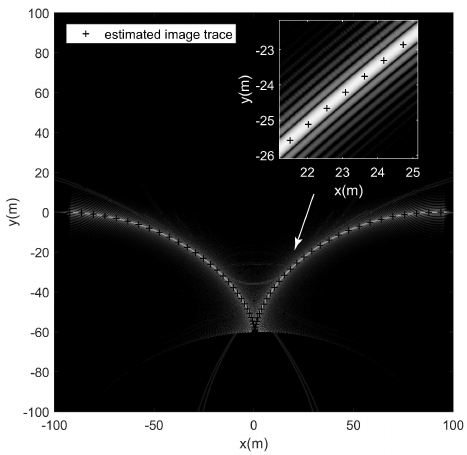
Figure 9. Estimated image trace and moving target SAR